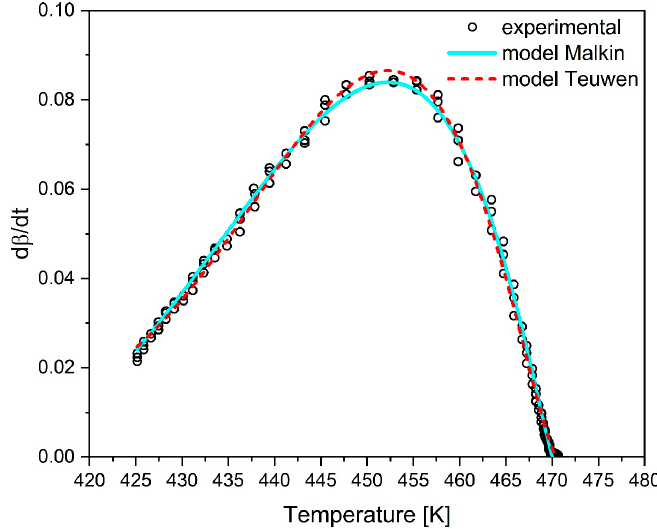
Figure 2. Comparison of the kinetic models by Malkin and Teuwen with experimental values of formulation F4.